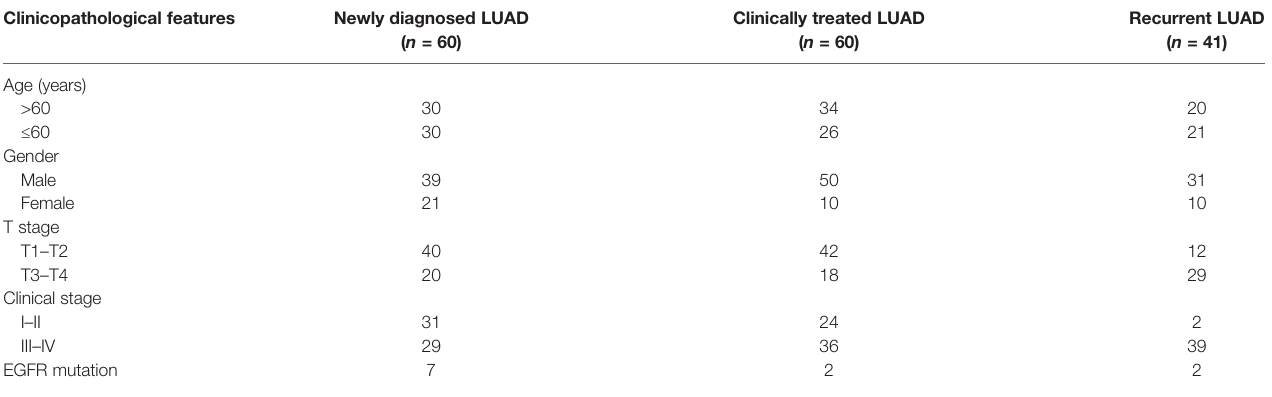
TABLE 1 | Clinical characteristics of the included LUAD cases for the analysis of serum and exosomal LDHC mRNA expressions. Clinicopathological features Newly diagnosed LUAD